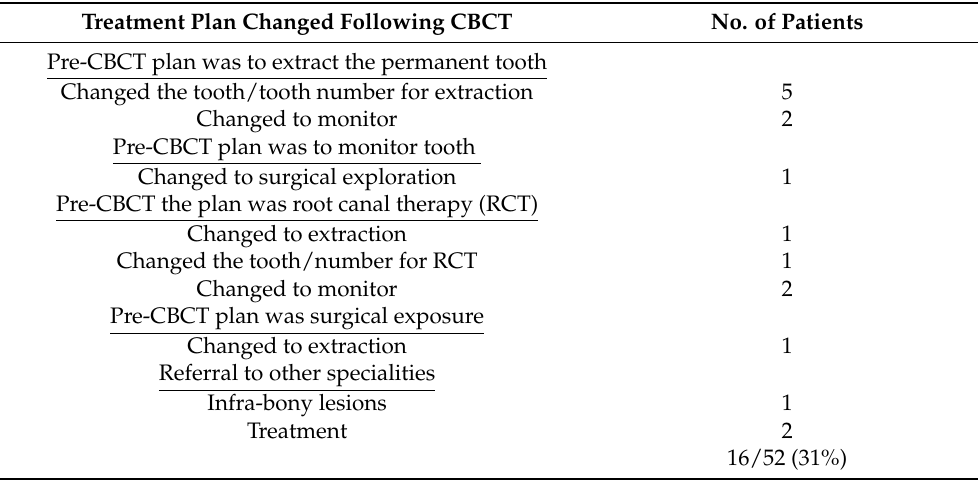
Table 5. Table showing how the treatment plans were changed following the CBCT examination. Treatment Plan Changed Following CBCT No. of